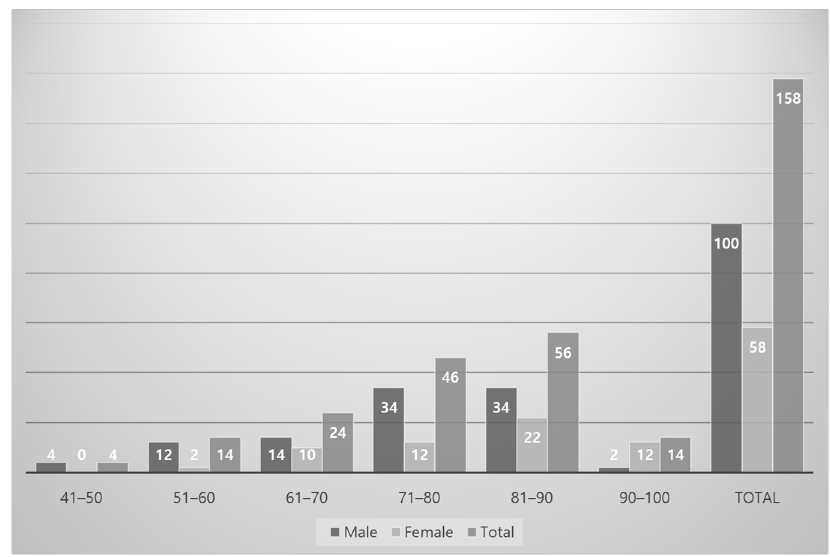
Figure 1. Gender and age distribution of Korean cadavers ( n = 158 feet).